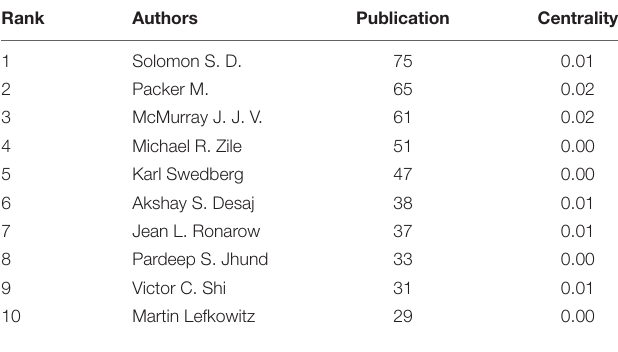
TABLE 3 | Top 10 authors in terms of number and centrality of articles related to ARNI in cardiovascular system